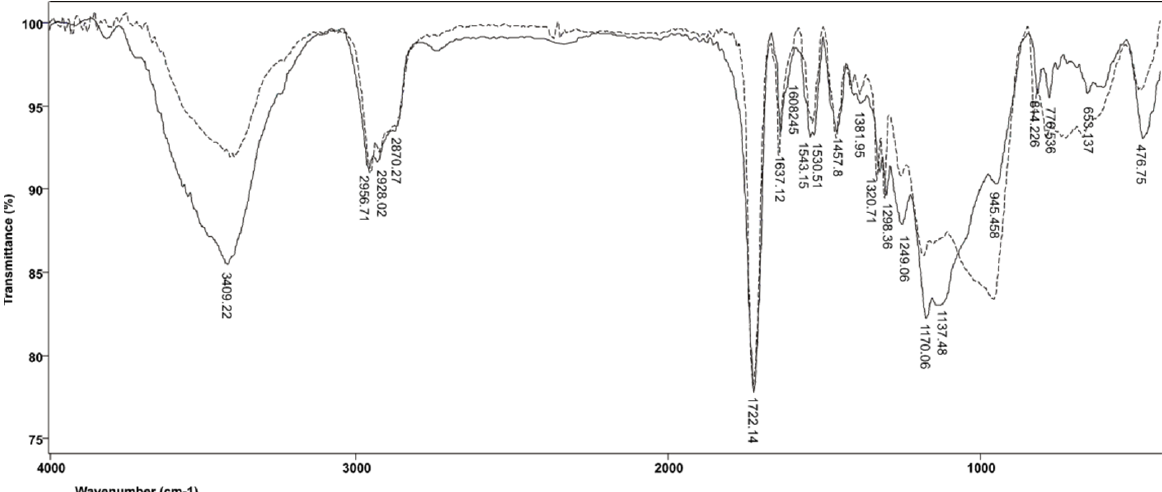
Figure 4. FTIR spectrum produced by the SpeedCEM resin before and after polymerization.